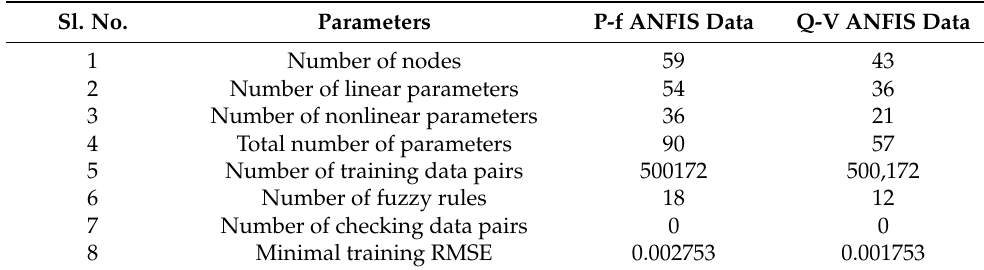
Table 9. ANFIS structure train data of Q-V and P-F.